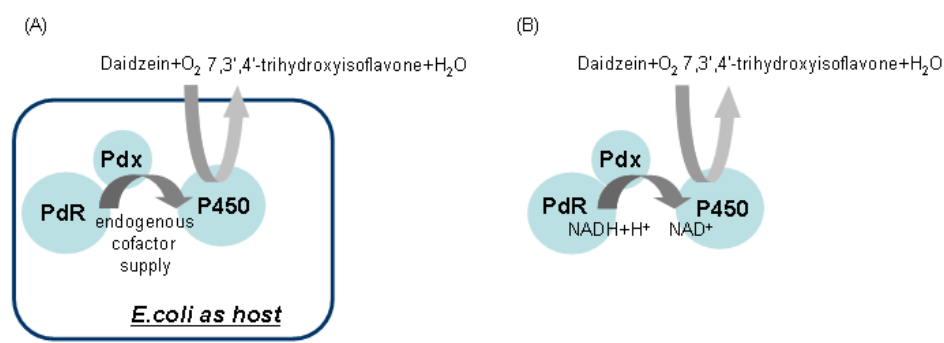
activity in daidzein hydroxylation in the whole cell reaction with CYP105D7. Figure 5 shows GC-MS mass spectra of daidzein and the 3'-hydroxylated daidzein product obtained with PdR and Pdx. Figure 4. Schematic representation of the in vivo and in vitro reaction designed for daidzein hydroxylation.